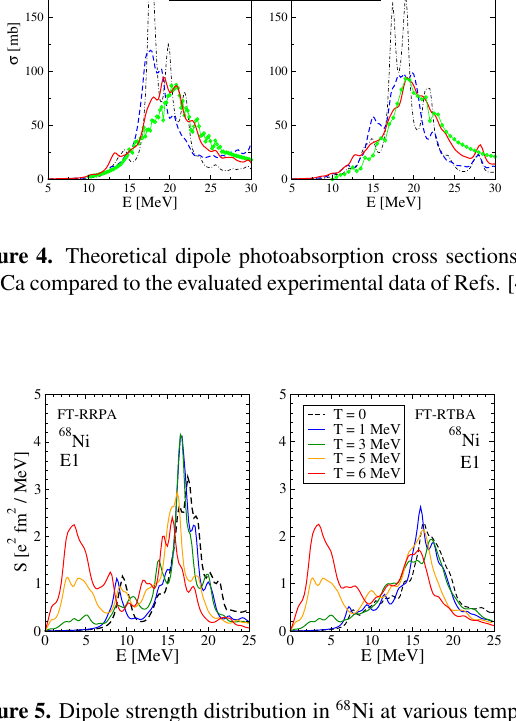
Figure 5. Dipole strength distribution in 68 Ni at various temper- atures in the finite-temperature relativistic RPA (FT-RRPA) and in the finite-temperature relativistic time blocking approximation